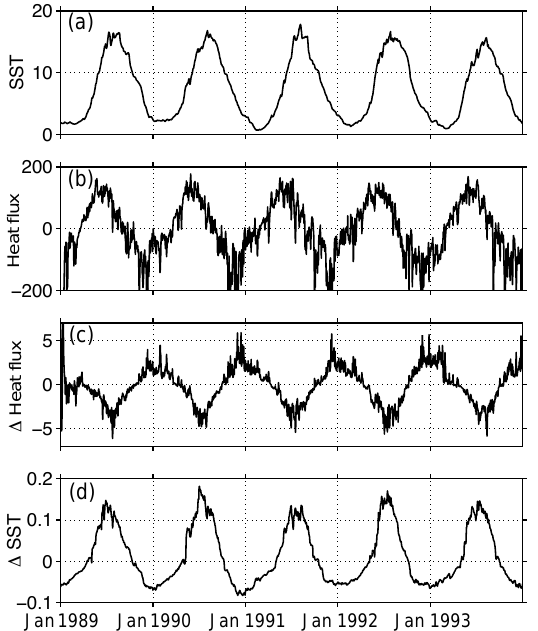
Figure 1. Basin-scale averaged temporal evolution of (a) sea sur- face temperature (upper panel, units ◦ C), (b) air–sea heat fluxes (second panel, units Wm − 2 ), (c) air–sea heat flux differences (third panel, units Wm − 2 ), and (d) sea surface temperature differences (lowermost panel, units K). The differences (cid:49) are calculated as experiment REF – noCW. Positive (negative) (cid:49) heat flux values denote reduced cooling (warming) in winter (summer) by surface current–wind effects. Likewise, positive (cid:49) SST (negative) values indicate warming (cooling) by surface current–wind effects.